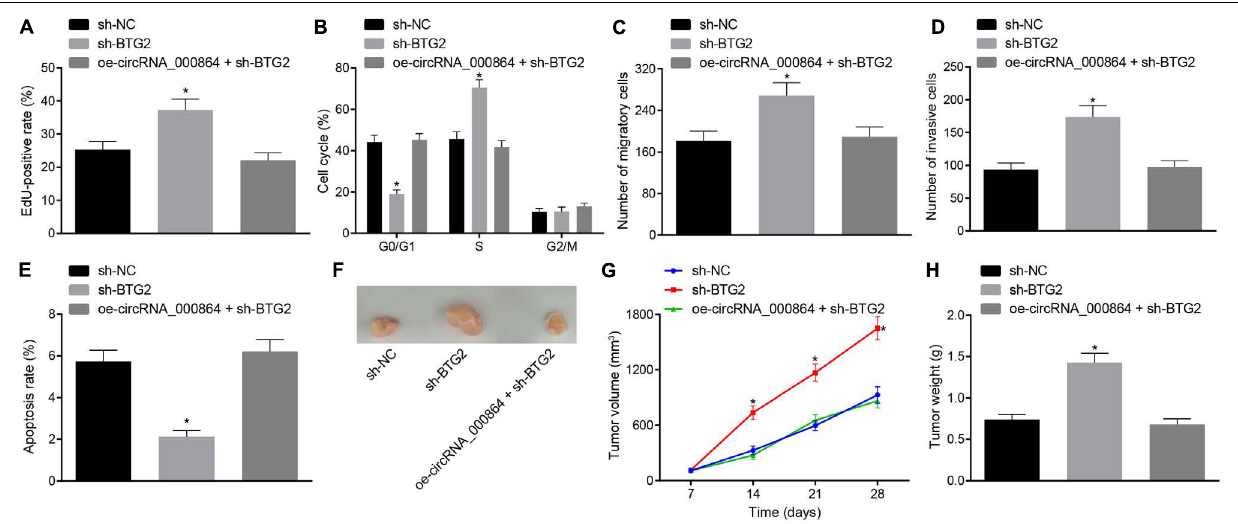
FIGURE 7 | CircRNA_000864 represses proliferation, migration, invasion, and antiapoptosis of pancreatic cancer cells by upregulating BTG2. AsPC-1 cells were transfected with sh-NC, sh-BTG2, or oe-circRNA_000864 + sh-BTG2. (A) AsPC-1 cell proliferation detected by EdU assay. (B) AsPC-1 cell cycle distribution detected by flow cytometry. (C) AsPC-1 cell migration detected by Transwell assay. (D) AsPC-1 cell invasion detected by Transwell assay. (E) AsPC-1 cell apoptosis detected by flow cytometry. Mice were treated with sh-NC, sh-BTG2, or oe-circRNA_000864 + sh-BTG2. (F) Representative images of xenograft tumor formation in nude mice ( n = 6). (G) Tumor volume of mice ( n = 6). (H) Tumor weight of mice ( n = 6). * p < 0.05 vs. AsPC-1 cells transfected with sh-NC. The above data were all measurement data. Data of (G,H) were expressed as mean ± standard deviation. Data of (G) were analyzed by repeated measures ANOVA (Tukey’s post hoc test), and data of (H ) were compared using one-way ANOVA (Tukey’s post hoc test). The remaining statistical results were summarized as sample mean ± standard error. The rest of the data were compared by using unpaired t -test. The cell experiment was conducted three times independently.